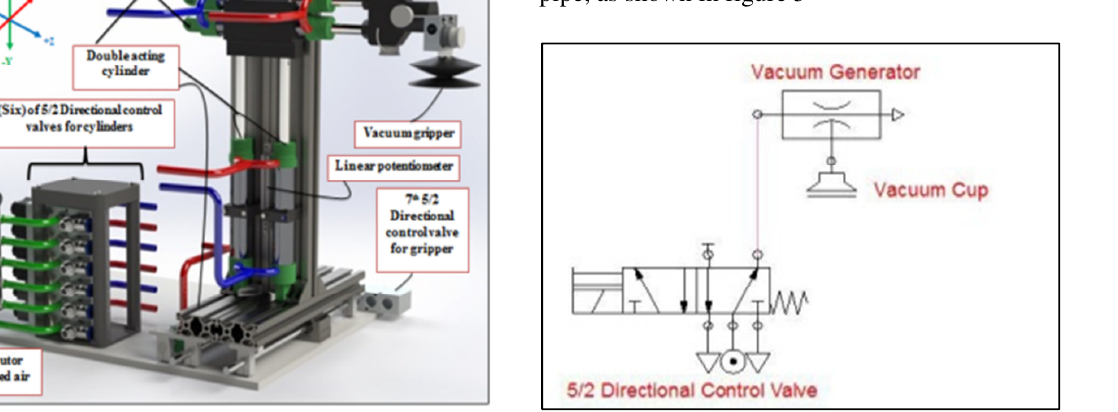
Fig. 3. 3D-module of the assembly parts.